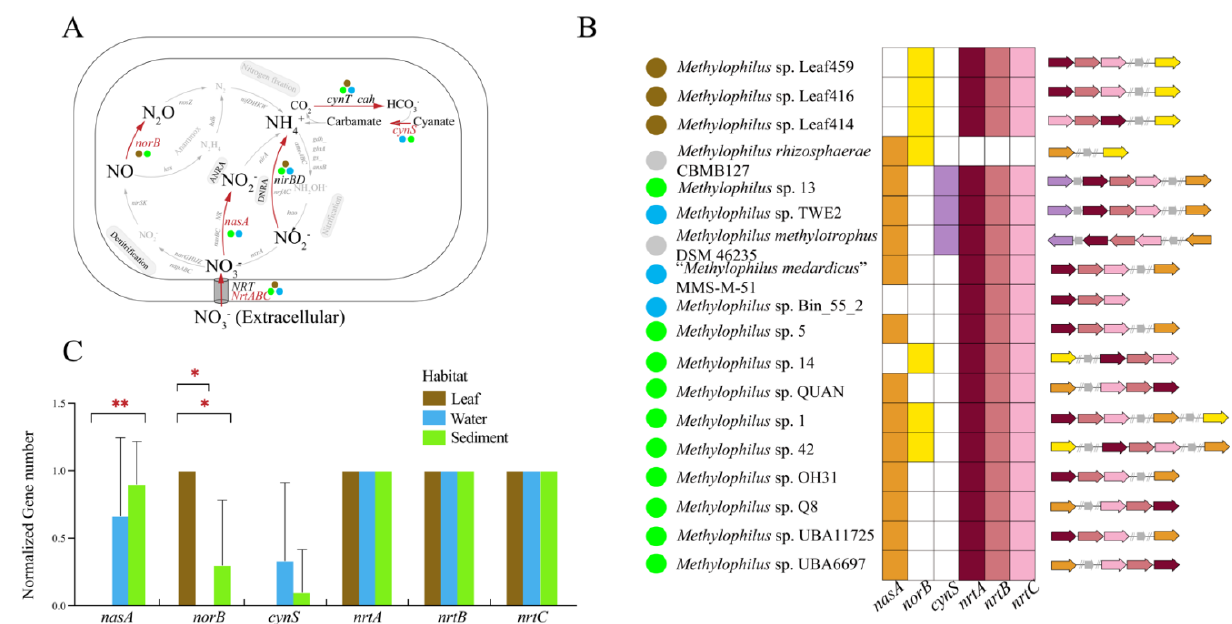
Figure 6. ( A ) Nitrogen metabolic pathway. Each step of the reaction is tagged with the corresponding genes. Genes that are present in all genomes are highlighted in black, while those that are present in partial genomes and absent in all of the genomes are highlighted in red and grey, respectively. ( B ) Distribution of partial nitrogen metabolism genes in Methylophilus genomes. The colored boxes indicate that the gene is present in the genome, whereas the white box indicates that it is absent. Functional gene clusters structural plot was performed according to the heatmap. The colored arrows correspond to the colored boxes. The grey arrows represent unknown genes. The solid circles with colors, blue, brown, green and grey, represent isolation sources, water, leaf, sediment and others, respectively. ( C ) Histogram constructed by computing the normalized number of partial nitrogen metabolism genes involved in ( B ). Three box colors represented three environments. Significant differences in nasA gene between leaf versus sediment and in norB gene between leaf versus sediment and water versus sediment by One-Way ANOVA. **: p < 0.01; *: p < 0.05.